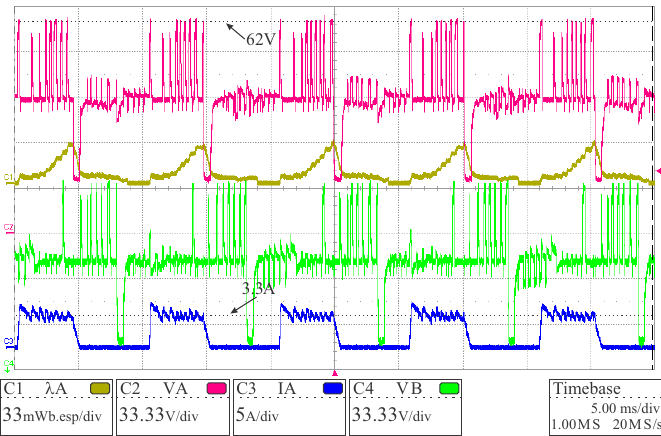
Figure 15. Experimental results: terminal voltages of consecutive phases (phase A and phase B